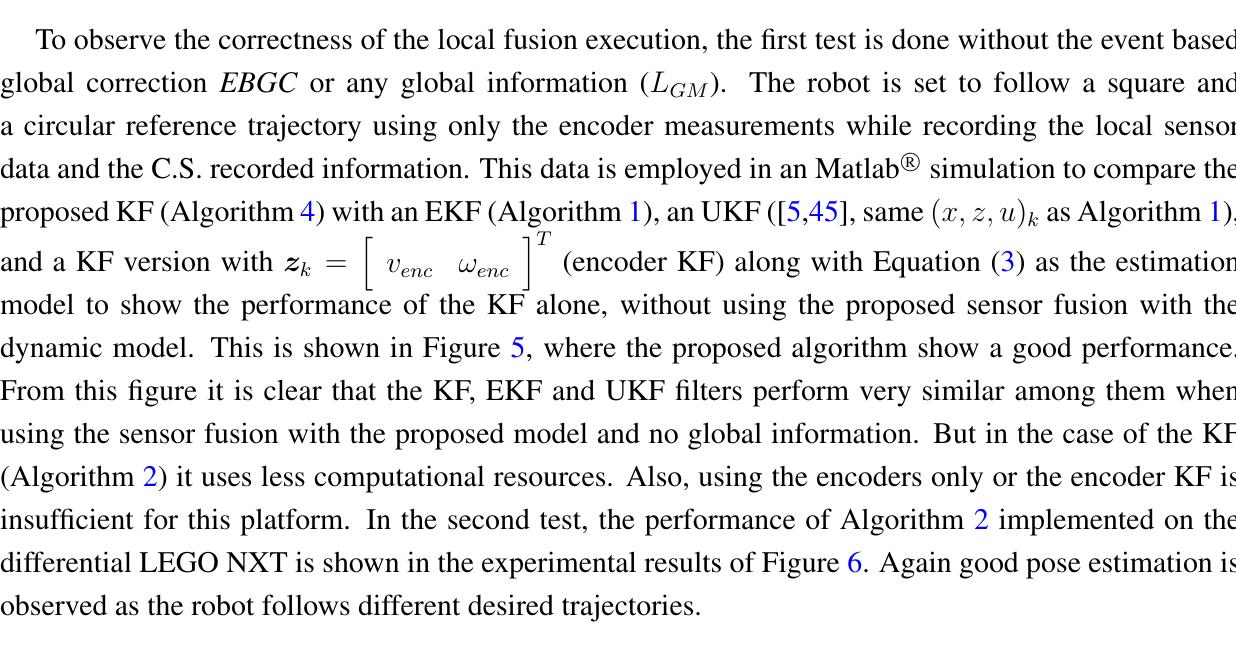
Figure 5. Algorithms performance in the differential platform, simulation test. ( a ) Square; ( b )